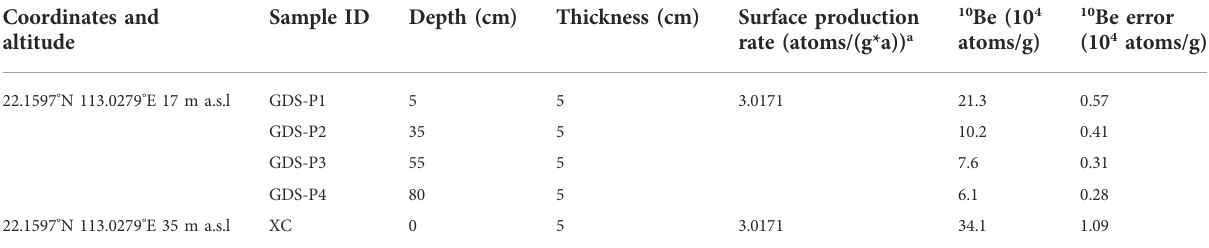
TABLE 1 10 Be sample locations and analysis.